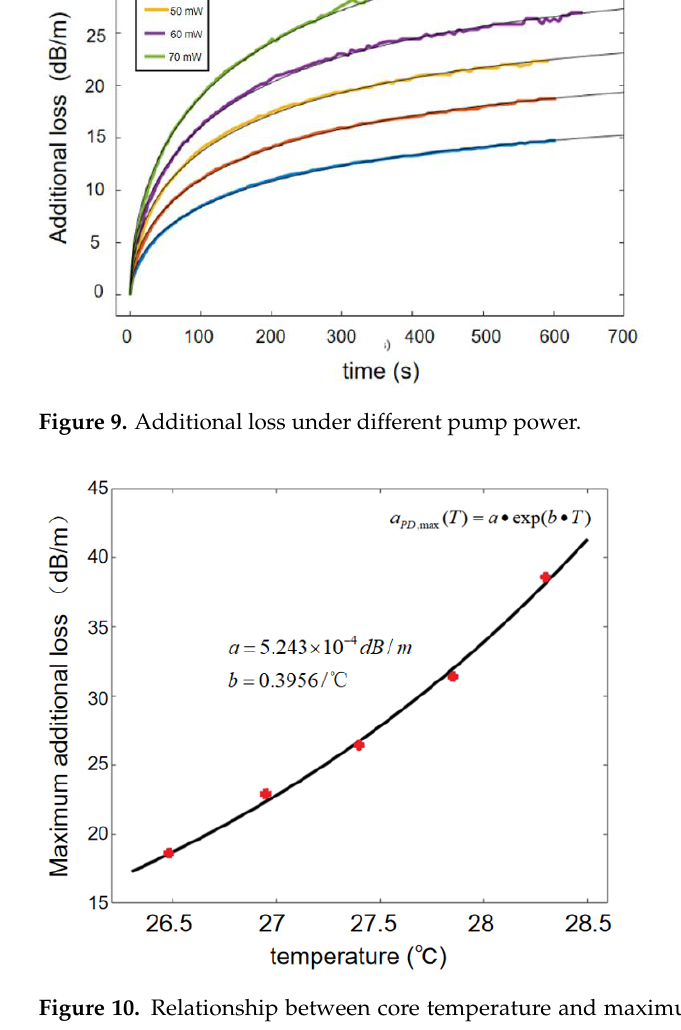
Figure 10. Relationship between core temperature and maximum additional loss. a and b in the figure is the fitting parameter.